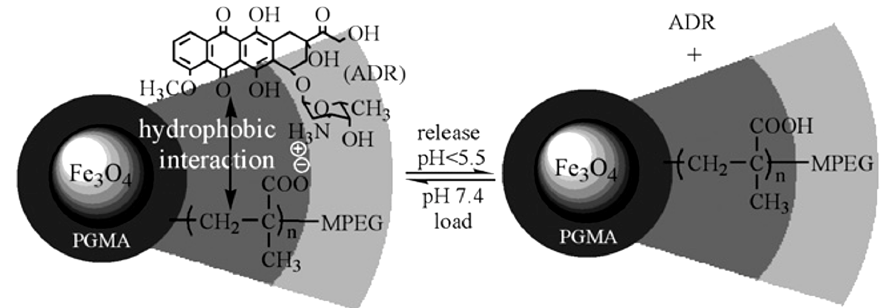
Figure 5. Schematic structure of mPEG- b -PMAA- b -PGMA-Fe adriamycin at neutral pH, designed to release the anticancer drug in the acidic environment of a tumor. mPEG: poly(ethylene glycol) monomethyl; PMAA: poly(methacrylic acid); PGMA: poly(glycerol methacrylate); and ADR: antitumor drug adriamycin. Reprinted with permission from [26]. Copyright 2008 Royal Society of